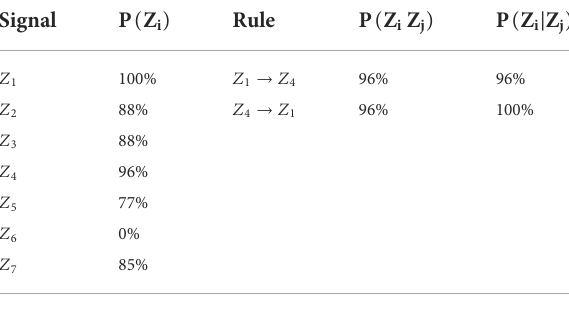
TABLE 4 Transaction dataset of 35 kV and below transmission lines.